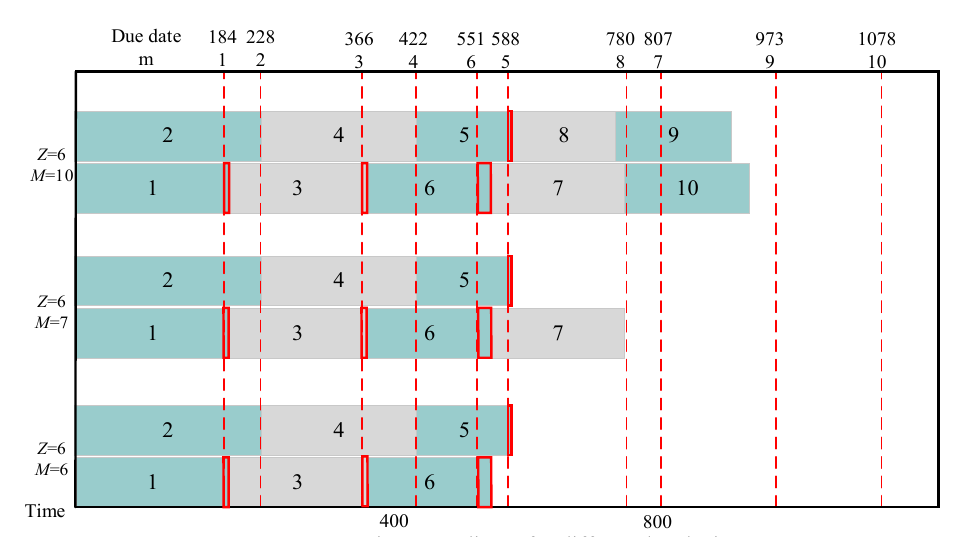
Fig. 2. Maximum tardiness for different batch